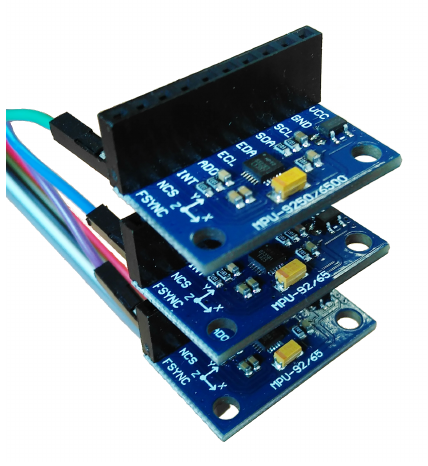
Figure 9. Inertial sensors block. Table 1. Main characteristics of the inertial sensor